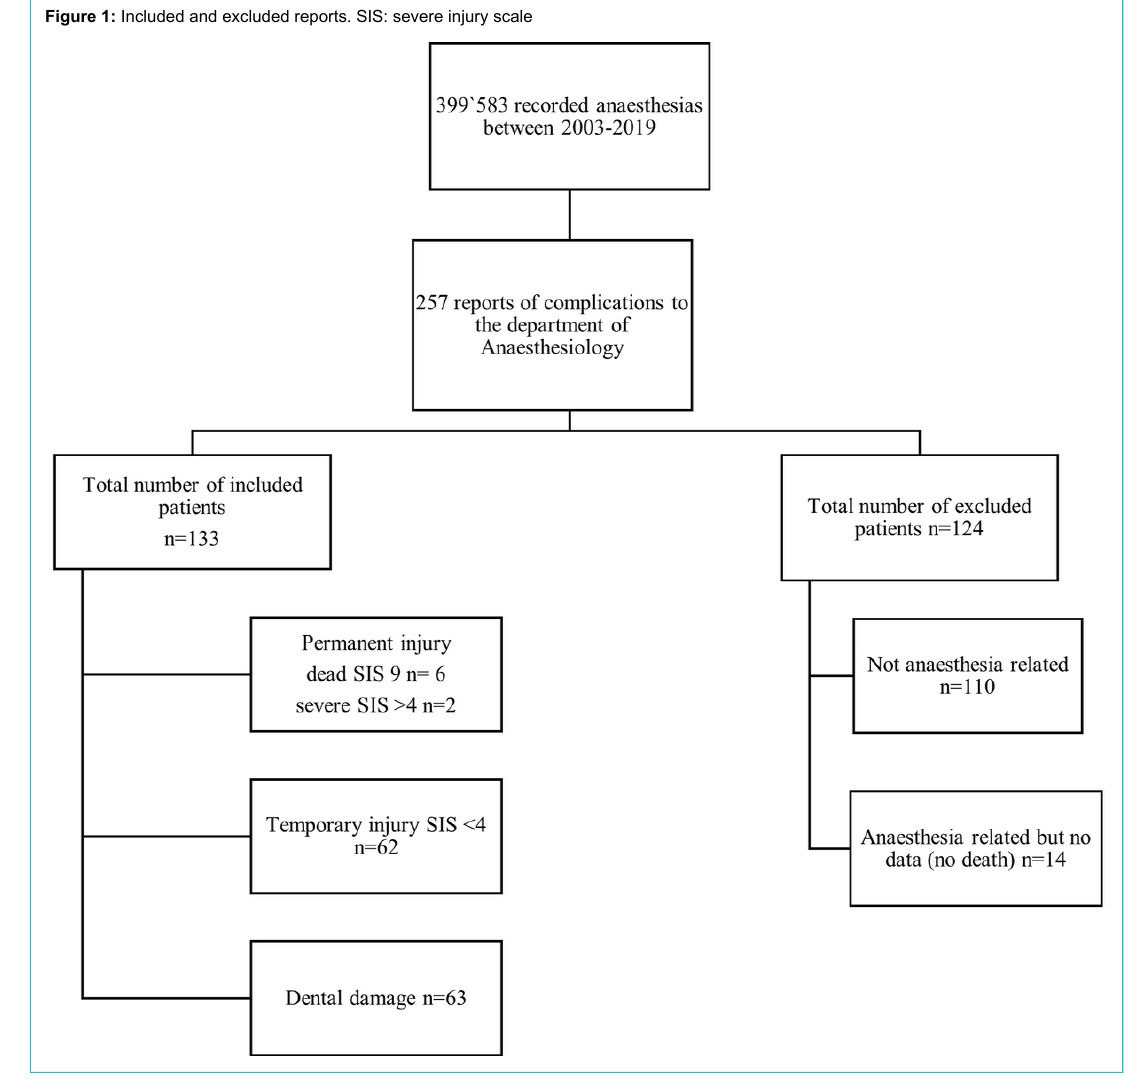
Figure 1: Included and excluded reports. SIS: severe injury